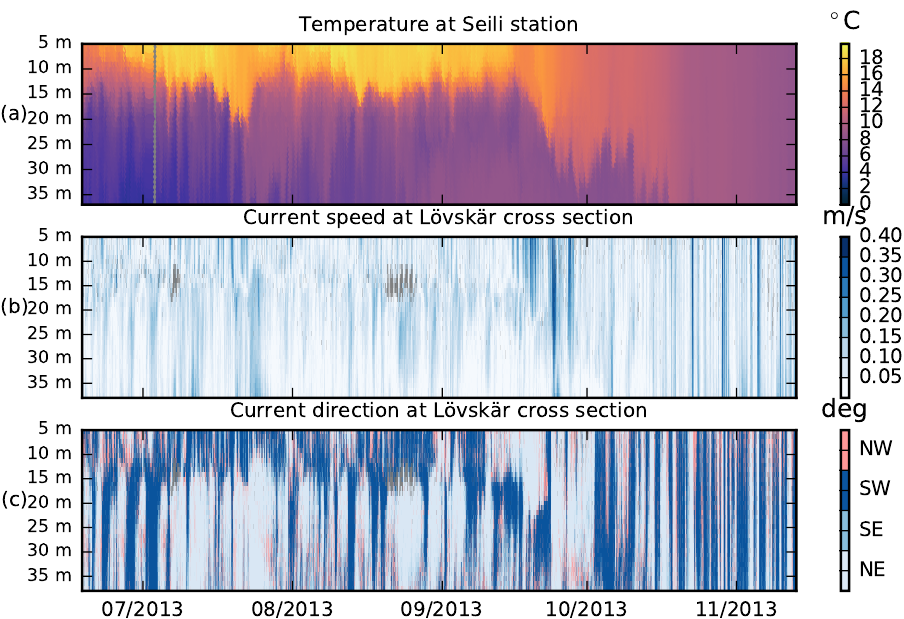
Figure 6. Temperature at Seili station ( a ), current magnitude ( b ) and the direction ( c ) at Lövskär cross section. Seili measurements have vertical coverage of 2–45 m, but only depths with the same range as current measurements are shown in this figure. Missing data points are shown as grey.